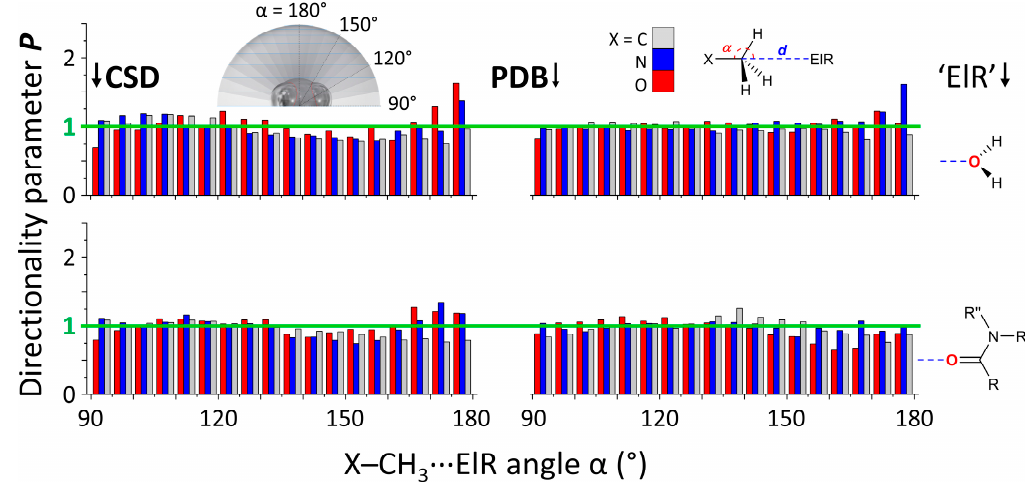
Figure 2. P ( α ) directionality plots for the data retrieved from the CSD (left) and the PDB (right) using the general query shown in the top-right inset figure for X–CH 3 ··· ElR pairs. X can be C, N or O and ‘ElR’ can be a water or an amide O-atom. The insert figure in the top left is intended as a guide to the eye to interpret the spatial location of data with a certain value of α . Due to the amount of data per dataset (see Table S1 for numerical overview), the plots are given at a 5 ◦ resolution for α . A full set of P ( α ) plots (i.e., for all the X vs ElR pairs in Figure 1) is given in Figure S1. The P value of 1 is highlighted in green and indicates a random distribution of data. N (CSD/PDB) = 46,000/29,508 (C, water); 18,170/17,101 (N, water); 7190/11,392 (O, water); 53,473/22,538 (C, amide); 7663/10,855 (N, amide); 9,158/11,064 (O, amide).